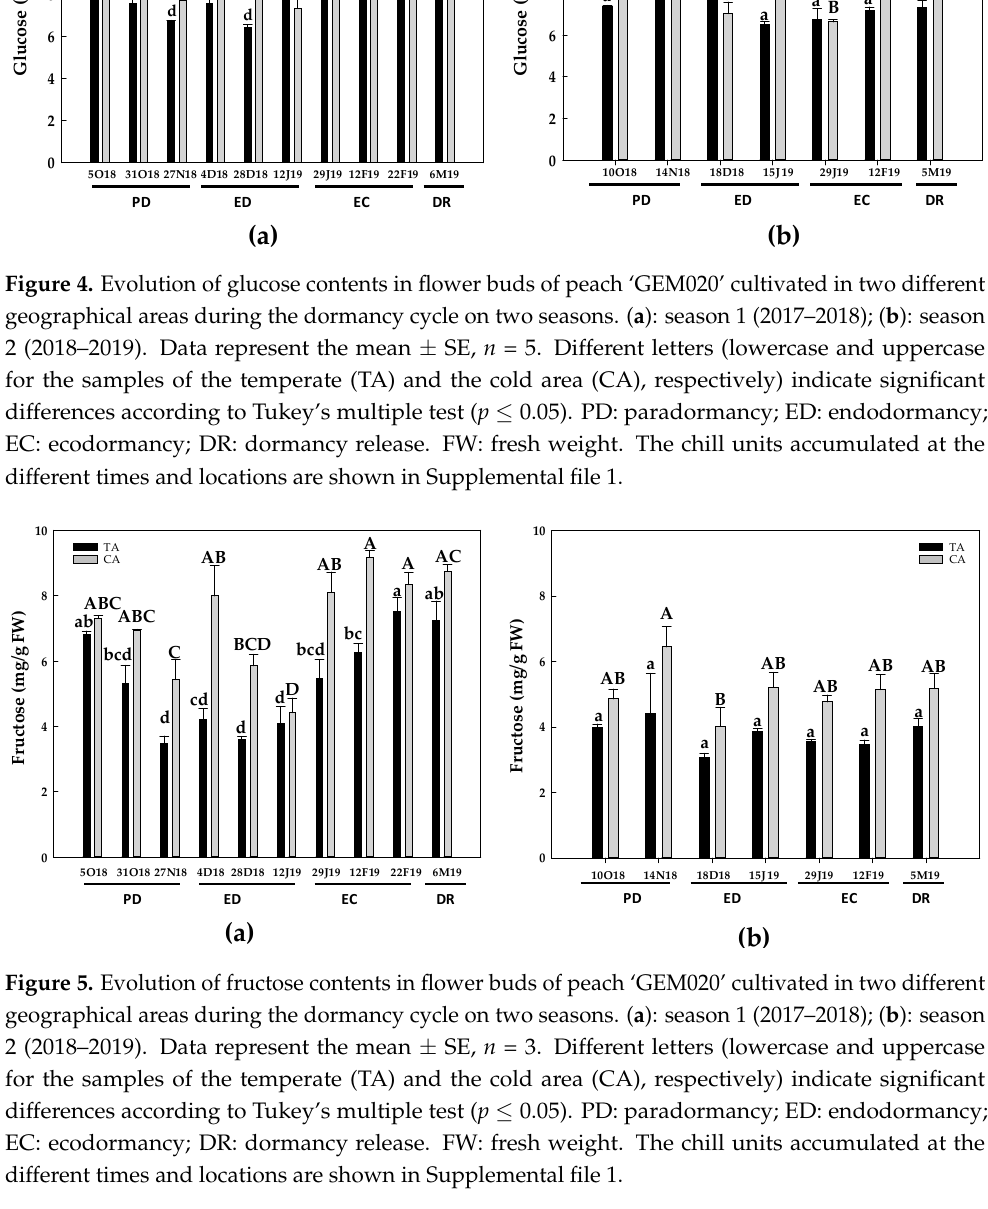
Figure 6. Evolution of sorbitol contents in flower buds of peach ‘GEM020’ cultivated in two dif- ferent geographical areas during the dormancy cycle on two seasons. ( a ): season 1 (2017–2018); ( b ): season 2 (2018–2019). Data represent the mean ± SE, n = 5. Different letters (lowercase and upper- case for the samples of the temperate (TA) and the cold area (CA), respectively) indicate significant